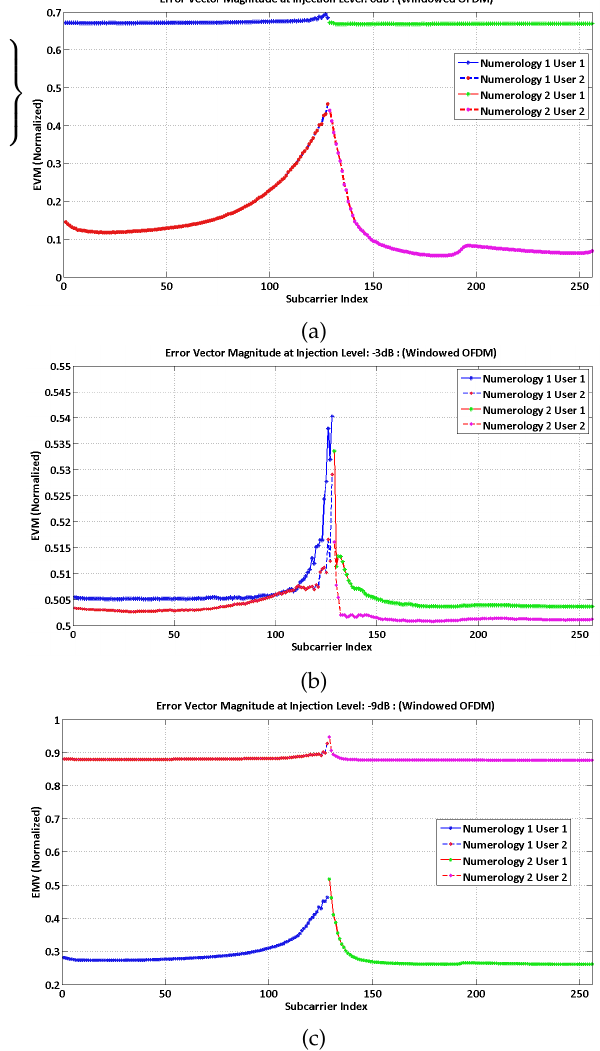
Fig. 7. Windowed CP-OFDM under NOMA Scenario - EVM v/s subcarrier index at an injection levels of (a) 0 dB, (b) − 3 dB & (c) − 9